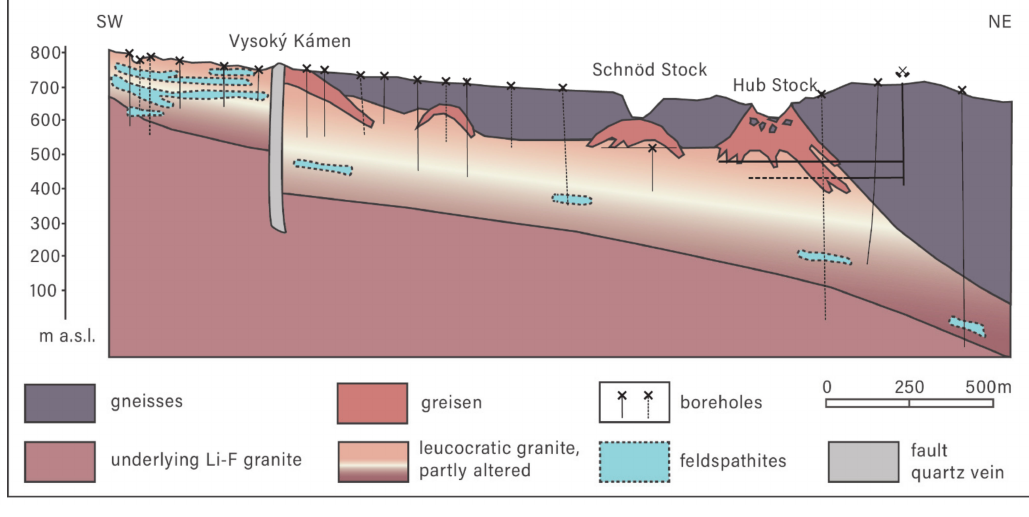
Figure 2. Cross-section through the Kr á sno-Horn í Slavkov ore district (modified after [36]). Bodies of feldspathites intersected by exploratory drilling are probably not of strictly lenticular shape, but their lateral extent is unclear (marked dashed line). They might in fact present large sheet bodies as in the left side of the picture (modified after